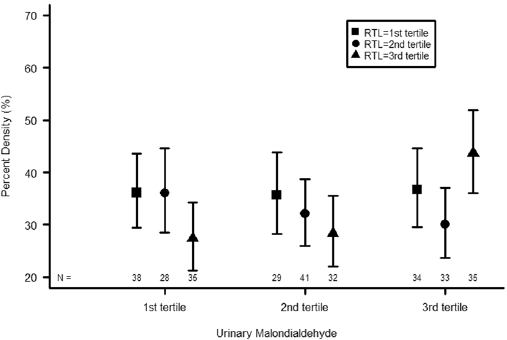
Figure 2. Percent mammographic density by tertiles of urinary MDA and RTL. Results are shown as least square means and standard error bars. P value for interaction between tertiles of MDA and tertiles of percent density = 0.02. MDA = malondialdehyde; RTL = relative telomere